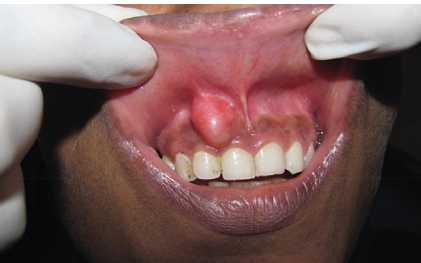
Figure 1: Intraoral view of lesion in anterior maxillary region.